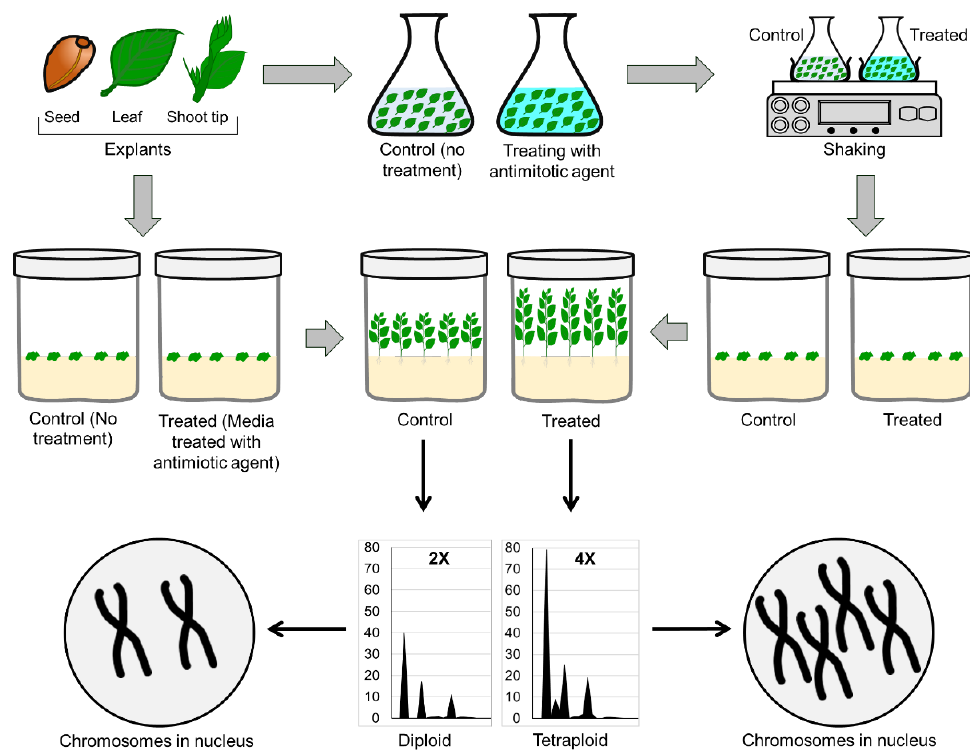
Figure 7. In vitro chromosome doubling (ploidy manipulation) for genetic diversification.